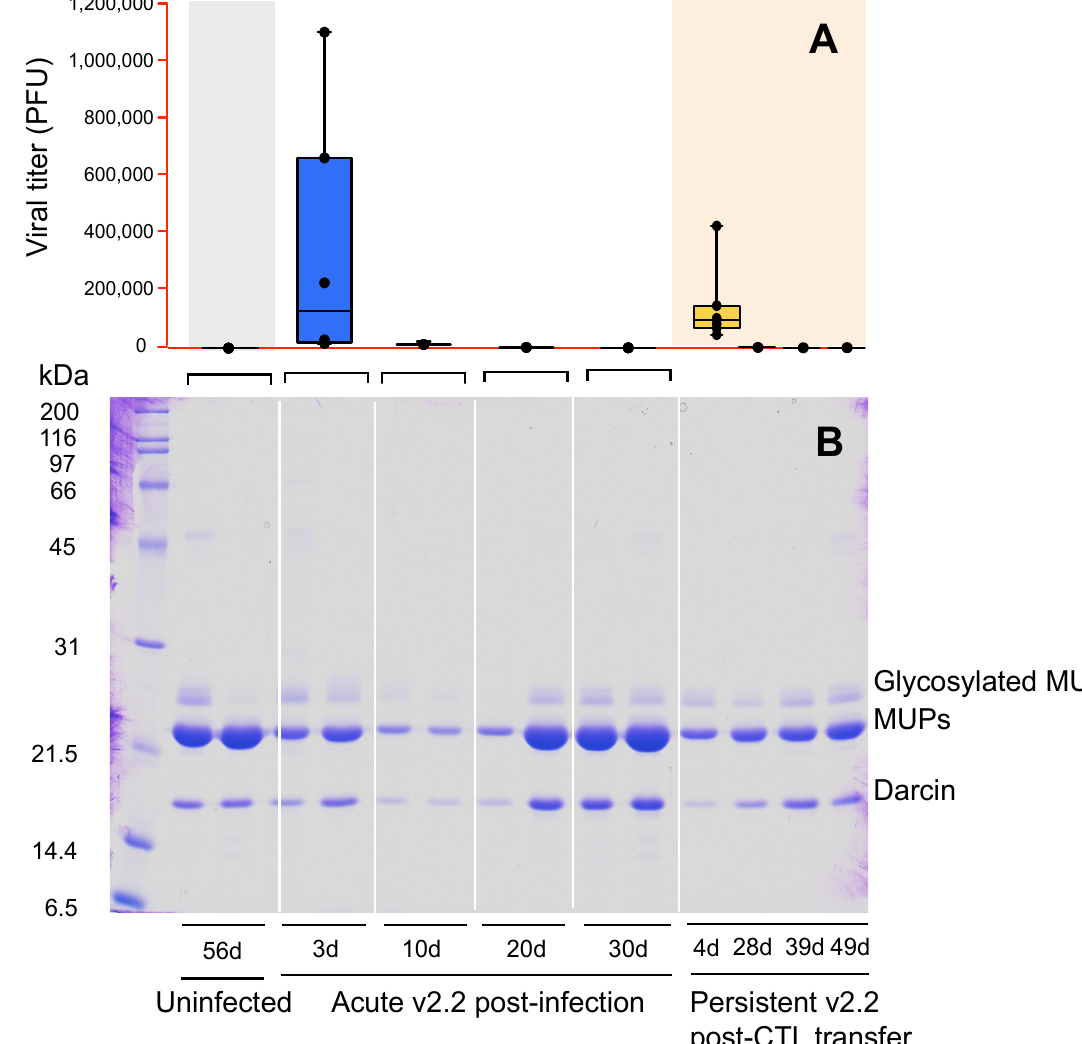
Figure 3. Typical urinary protein output during and after clearance of acute or persistent LCMV v2.2 infection. At 8 weeks of age, uninfected males were inoculated with v2.2 and blood and urine samples were analysed for viral titer ( A ) and urinary proteins (( B ), MUPs resolved by SDS-PAGE) at days 3 or 7, 10, 20 or 30 (N = 6 males per time point). Another group of males (N = 7), inoculated with v2.2 within 18 h of birth to generate persistent infection, were treated with adoptive virus-specific CTL transfer at 8 weeks of age and sampled during infection and recovery.